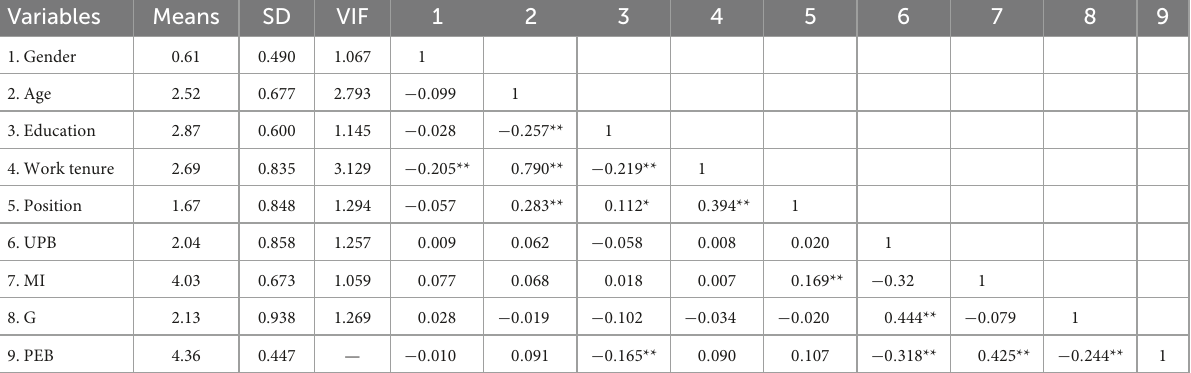
TABLE 4 Results of variable descriptive